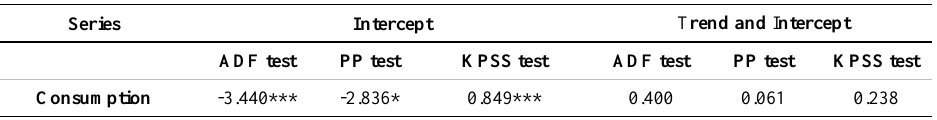
Table 2. Results of traditional unit root tests.